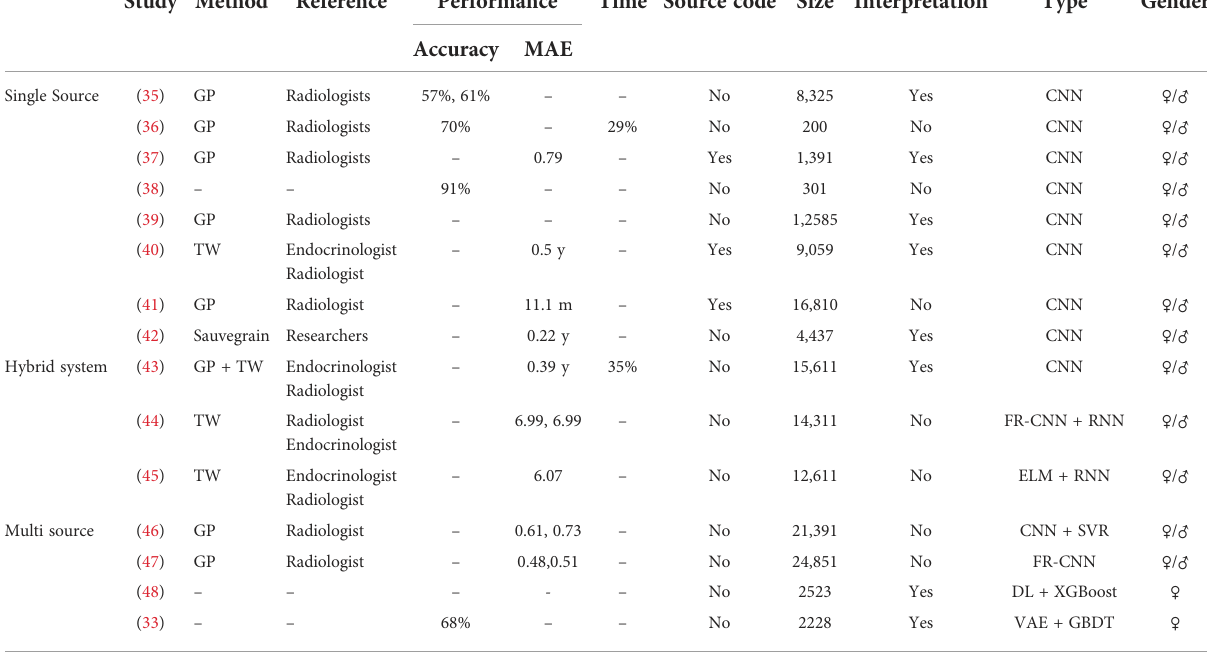
TABLE 3 DL-based studies for precocious puberty diagnosis. Study